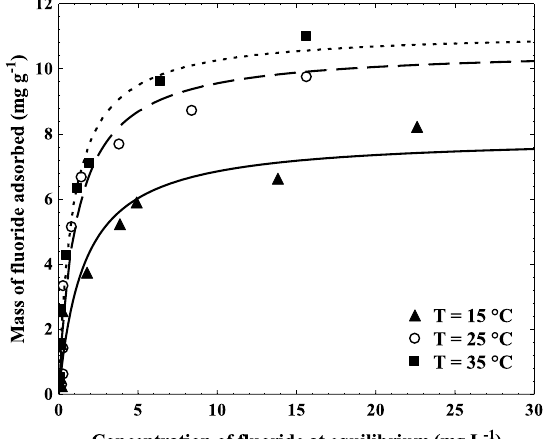
Fig. 10 Effect of temperature upon the capacity of BCM2 for adsorbing fluoride from aqueous solution at pH represent the Langmuir isotherm